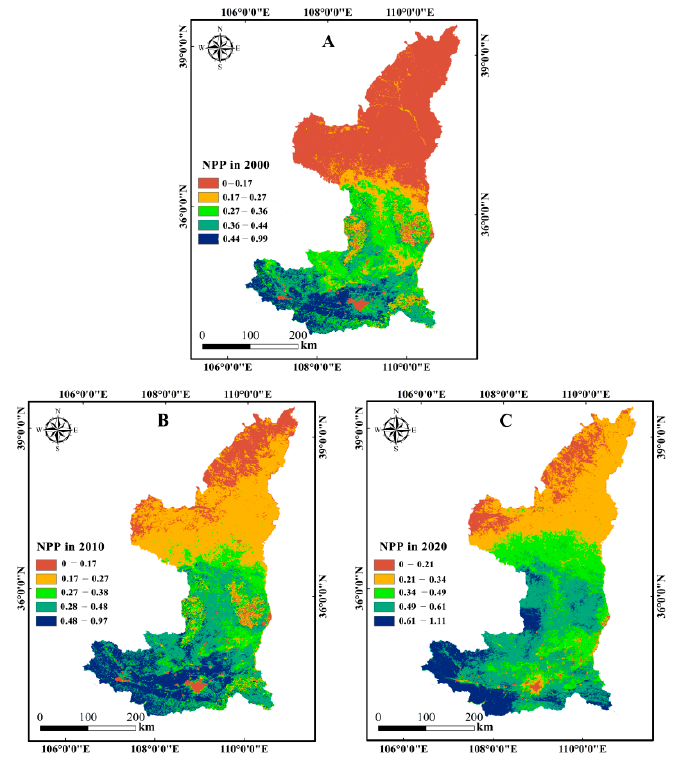
Figure 4. Distribution of NPP in the YRBS from 2000 to 2020 (raster mean). ( A ) 2000, ( B ) 2010, and ( C ) 2020. Unit: KgC/m 2 ·year.